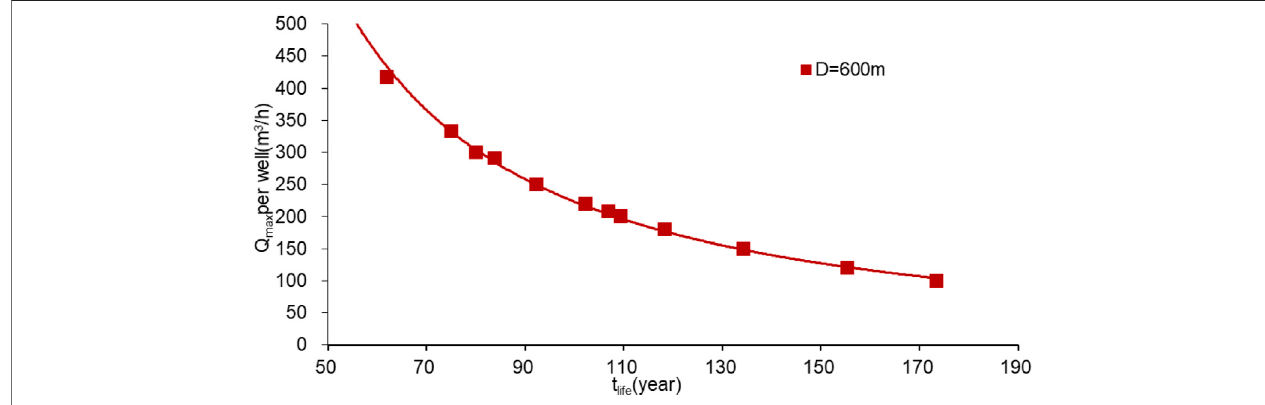
FIGURE 5 | Relationship between the time when thermal breakthrough occurred and the water yield per production